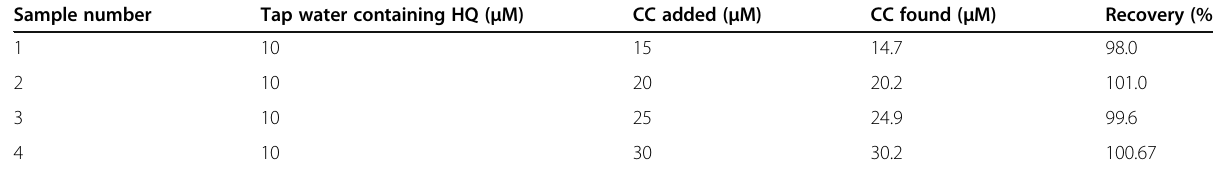
Table 3 Anti-interference results obtained for CC in tap water sample containing HQ at ALR/GCE ( n = 5) Sample